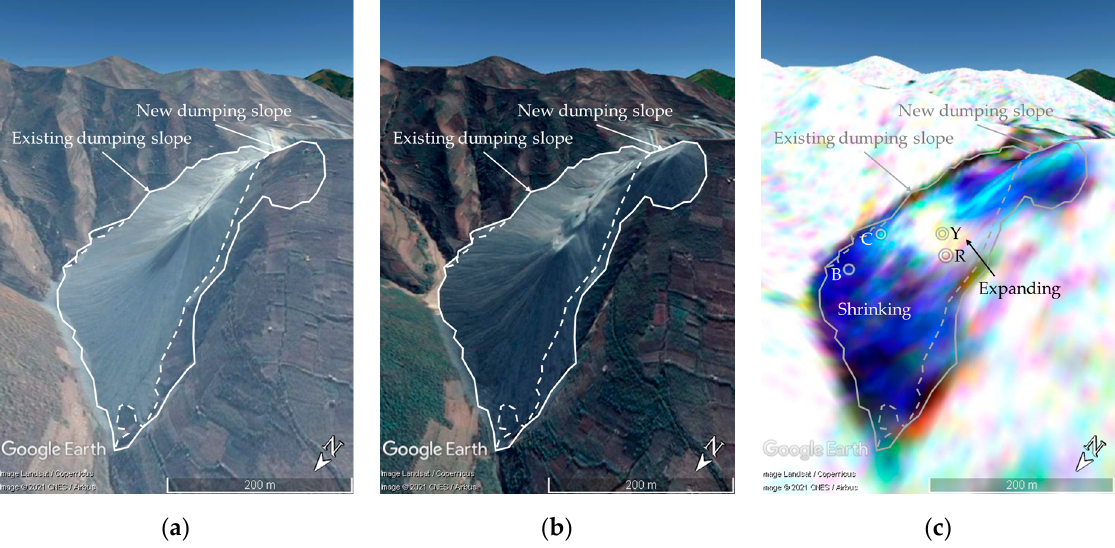
Figure 13. West Dumping Site 1 (WD1). ( a , b ) are Google Earth images taken on 7 October 2015 and 26 September 2019, respectively. ( c ) is the RGB composite of the annually averaged NDAI map (R: 2019, G: 2018, and B: 2017) with several color points where 12-day NDAI graphs are shown in Figure 14. Dashed lines are drawn based on the 2015 Google Earth image, while solid lines are on 2019.